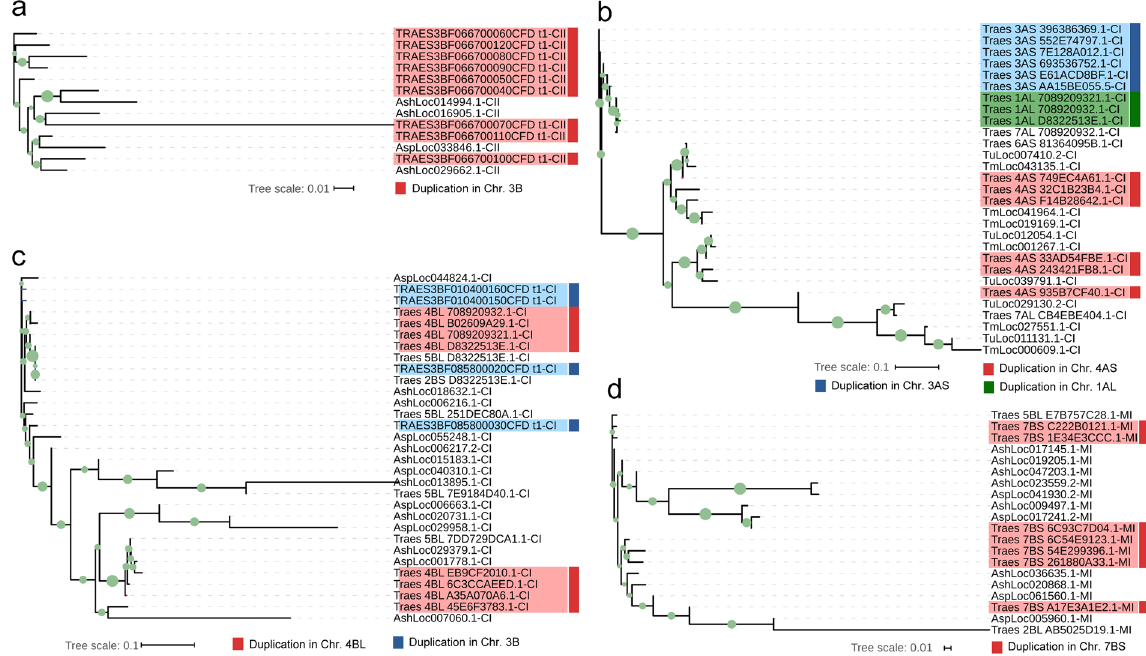
Figure 3. Gene expansions of subfamilies CI, CII and MI in subgenomes A and B. ( a ) Duplications of subfamily CII in subgenome B. ( b ) Duplications of subfamily CI in subgenome A. ( c ) Duplications of subfamily CI in subgenome B. ( d ) Duplications of subfamily MI in subgenome B. The bootstrap values are plotted as circles at the nodes with the circle size proportional to the bootstrap value. Abbreviations: Asp, Aegilops speltoides ; Ash, Aegilops sharonensis ; Tm, Triticum monococcum ; Tu, Triticum urartu ; Traes, Triticum aestivum